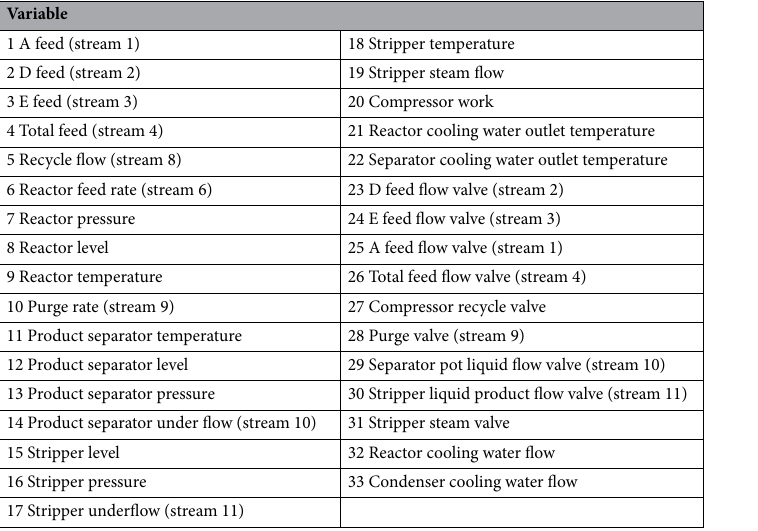
Table 2. Monitored variables in the Tennessee Eastman process 33